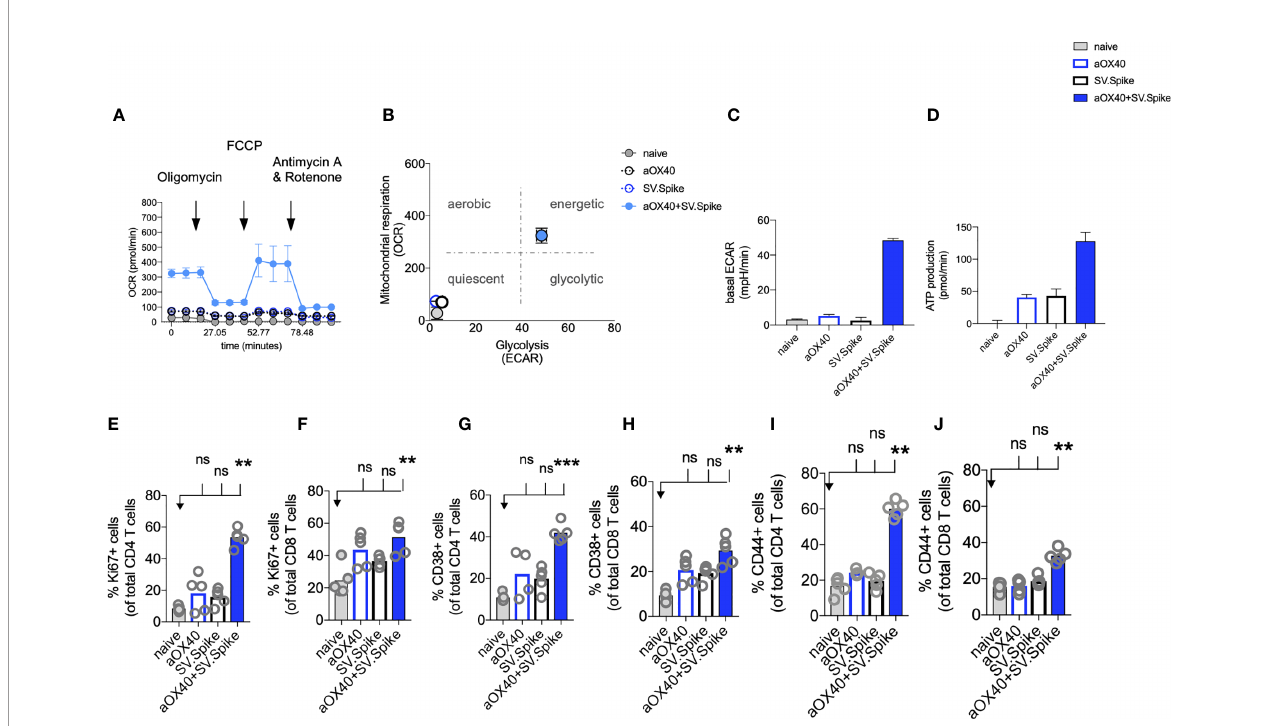
FIGURE 5 | SV.Spike in combination with a OX40 activates and metabolically reprograms T cells. C57BL/6J mice were vaccinated with fi rst doses of SV.Spike and/ or a OX40. Naive mice were used as control. T cells were isolated from spleens on day 7 or otherwise indicated. (A) Mitochondrial respiration was assessed by measuring the median values of oxygen consumption rates (OCR) in T cells of indicated groups using an extracellular fl ux analyzer. Oligomycin, FCCP, Antimycin A, and Rotenone were injected as indicated to identify energetic mitochondrial phenotypes. (B) Energy map (OCR versus ECAR) of T cells from naïve or mice treated with SV.Spike, or a OX40 or combination of SV.Spike+ a OX40 on day 7. (C) Baseline extracellular acidi fi cation rates (ECAR) in T cells of indicated groups. (D) ATP Production in T cells of indicated groups. (E – J) Splenocytes were analyzed in fl ow cytometry. (E, F) Expansion of CD4+ (E) and CD8+ T (F) cells is indicated by expression of Ki67-positive cells. (G, H) Activation of CD4+ T cells (G) and CD8+ T cells (H) indicated by CD38+ expression. (I, J) Expression of CD44+ positive cells. CD4 (I) and CD8 (J) cells. Error bars indicate SEM. Results are representatives of two independent experiments. Each symbol represents an individual mouse in (E – J) Bars represent means. Statistical signi fi cance was determined with the Kruskal-Wallis test followed by Dunns ’ test. n.s. > 0.05, **p<0.005, ***p ≤